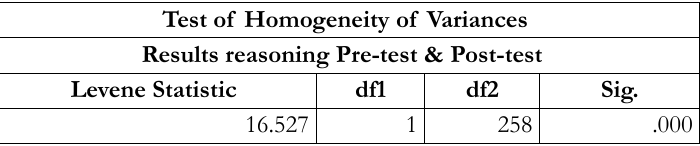
Table 13. Normality Test with Kolmogorov-Smirnov